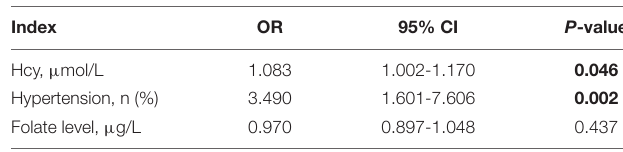
TABLE 3 | Multivariate logistic regression analysis between patients with RIA and those with